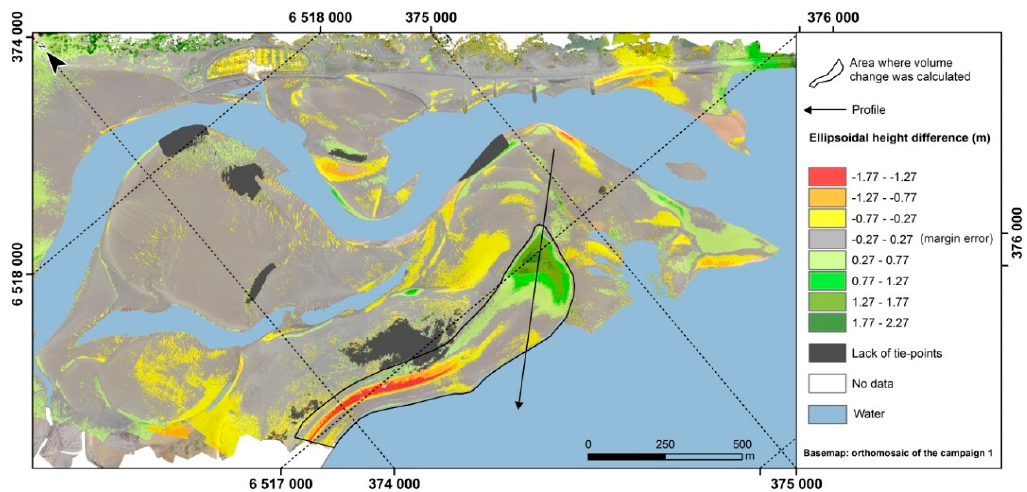
Figure 12. Ellipsoidal height difference during the studied period (from campaign 1 to campaign 2). The results are presented on the orthomosaic of the campaign 2. The shade of red corresponds to areas where erosion occurred and the shade of green corresponds to areas where accretion occurred. Light grey means that the changes are not significant according to the margin of error computed previously. Dark grey areas correspond to lack of tie points and white areas to no data. The arrow corresponds to the location of the topographic profile plotted on Figure 13.